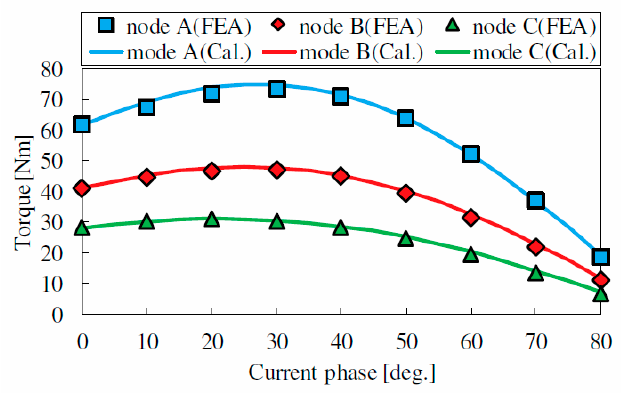
Figure 10. Calculated torque by Equation (5) and analyzed torque by FEA.